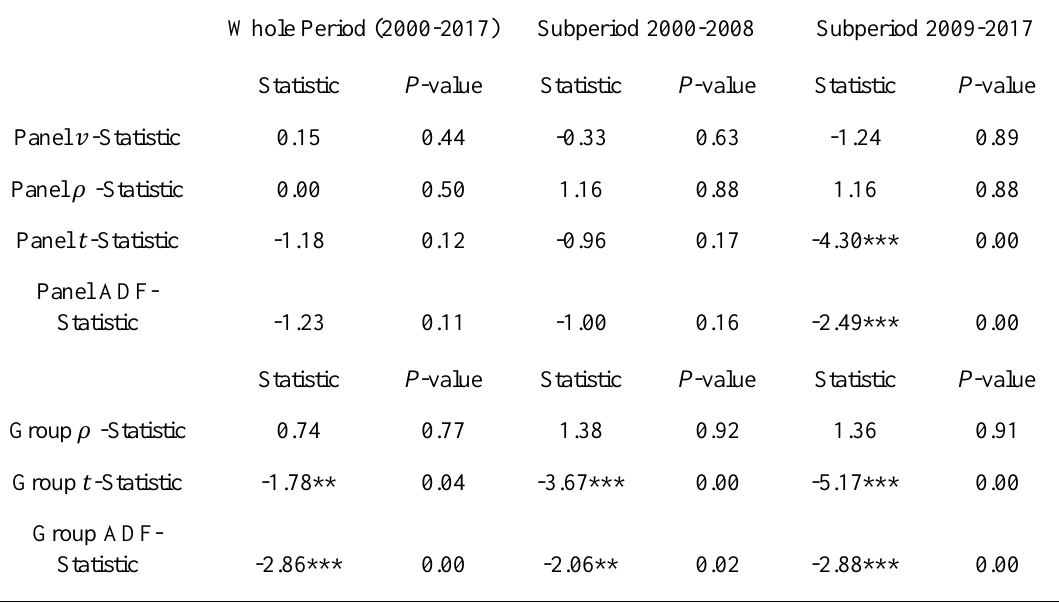
Table 1: Pedroni Heterogeneous Panel Cointegration Test Whole Period (2000-2017) Statistic P -value Statistic P -value Statistic P -value Panel 𝑣